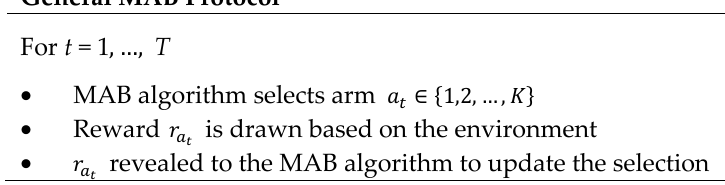
Figure 3. General multi-player multi-armed bandit (MAB) protocol.